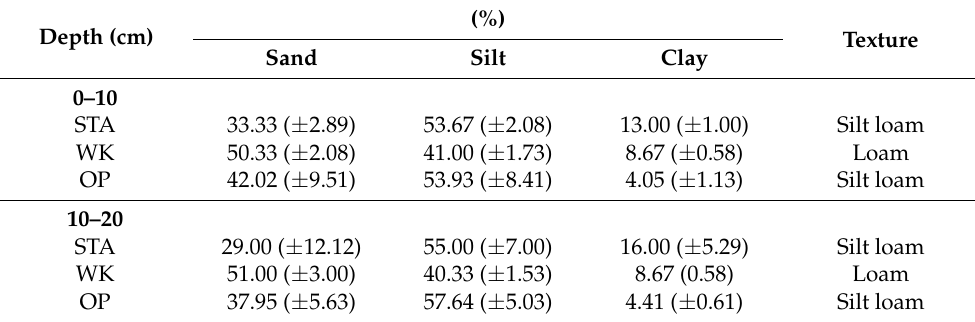
Table 1. Mean values ± standard deviation (n = 3) of soil granulometric composition in tree forests in the Vistula River floodplain (STA—Starogr ó d, WK—Wielka K˛epa, OP—Ostr ó w Panie´nski) in three soil layers (0–10 cm, 10–20 cm, 20–30